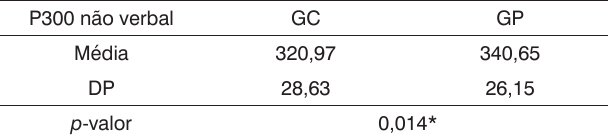
Tabela 2. Média, desvio-padrão e p -valor dos valores de latên